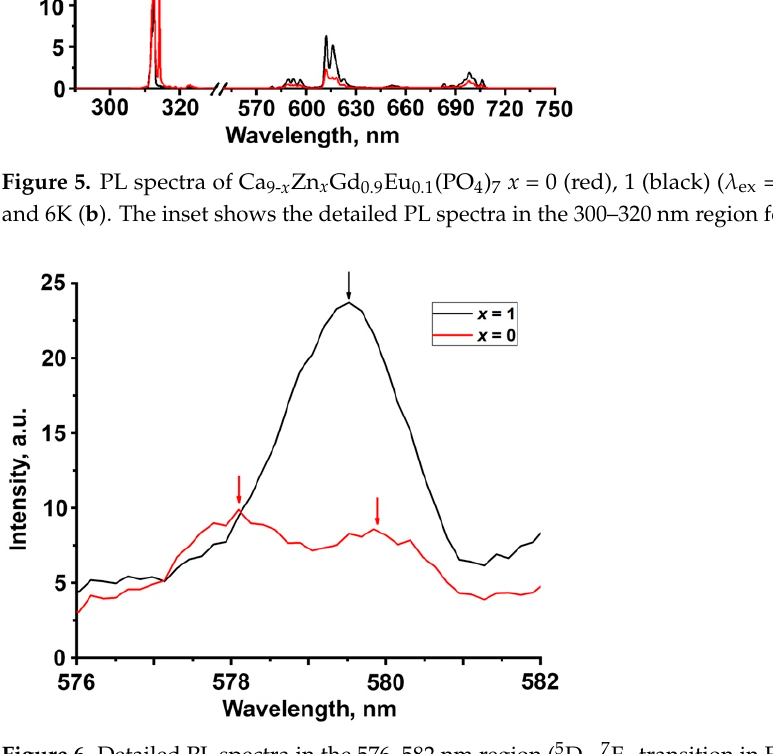
Figure 6. Detailed PL spectra in the 576–582 nm region ( 5 D 0– 7 F 0 transition in Eu 3+ ) measured at 6 K for Ca 9 − x Zn x Gd 0.9 Eu 0.1 (PO 4 ) 7 x = 0 (red), 1 (black).